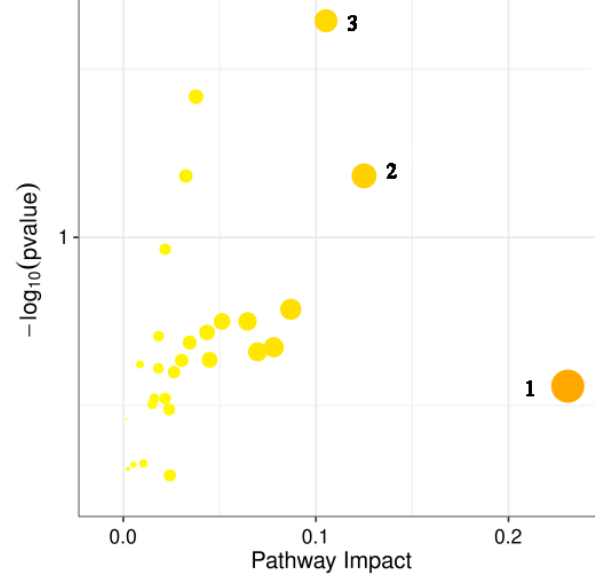
Figure 13. Metabolic pathway analysis based on the potential biomarkers. 1, glutathione metabolism; 2, aminoacyl-tRNA biosynthesis; 3, linoleic acid metabolism.